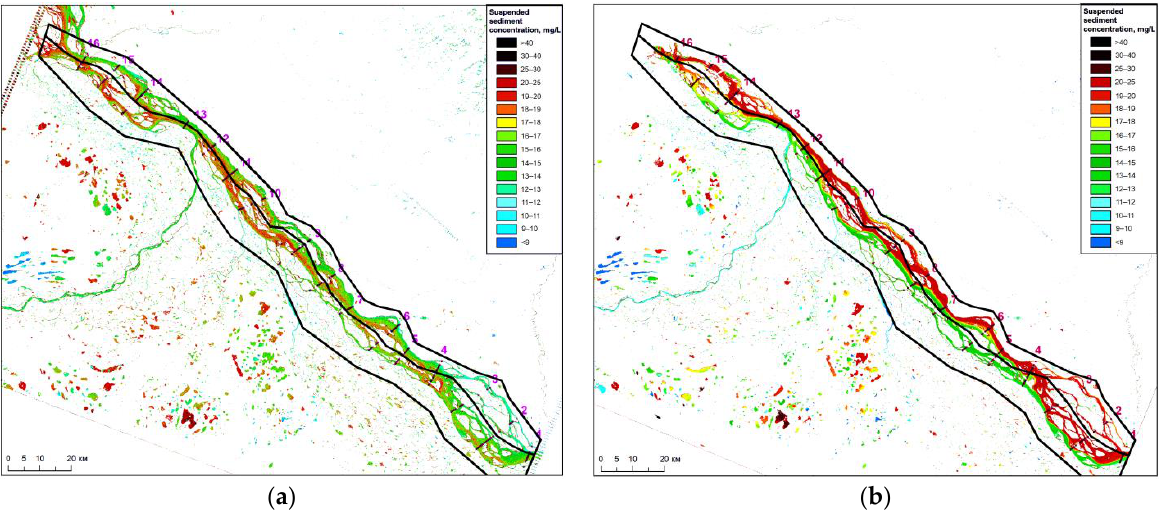
Figure 9. Examples of SSC maps along case study 2 demonstrating significant domination of the Lena River water discharge over the Aldan river ( a ) — 28 August 2009, Q L /Q A = 3.53 River water discharge over the Aldan river ( a )—28 August 2009, Q L /Q A = 3.53 (Q L = 17,700 m 3 s − 1 , (Q L = 17,700 m 3 s −1 , Q A = 5 100 m 3 s −1 ) , discharge ratio group — 1) and domination of the Aldan River Q A = 5 100 m 3 s − 1 ) , discharge ratio group—1) and domination of the Aldan River discharge over the discharge over the Lena river ( b ) — 31 August 2016, Q L /Q A = 0.74 (Q L = 13,200 m 3 s −1 , Q A = 9 730 m 3 s −1 ), Lena river ( b )—31 August 2016, Q L /Q A = 0.74 (Q L = 13,200 m 3 s − 1 , Q A = 9 730 m 3 s − 1 ), discharge discharge ratio group — 4). ratio group—4).